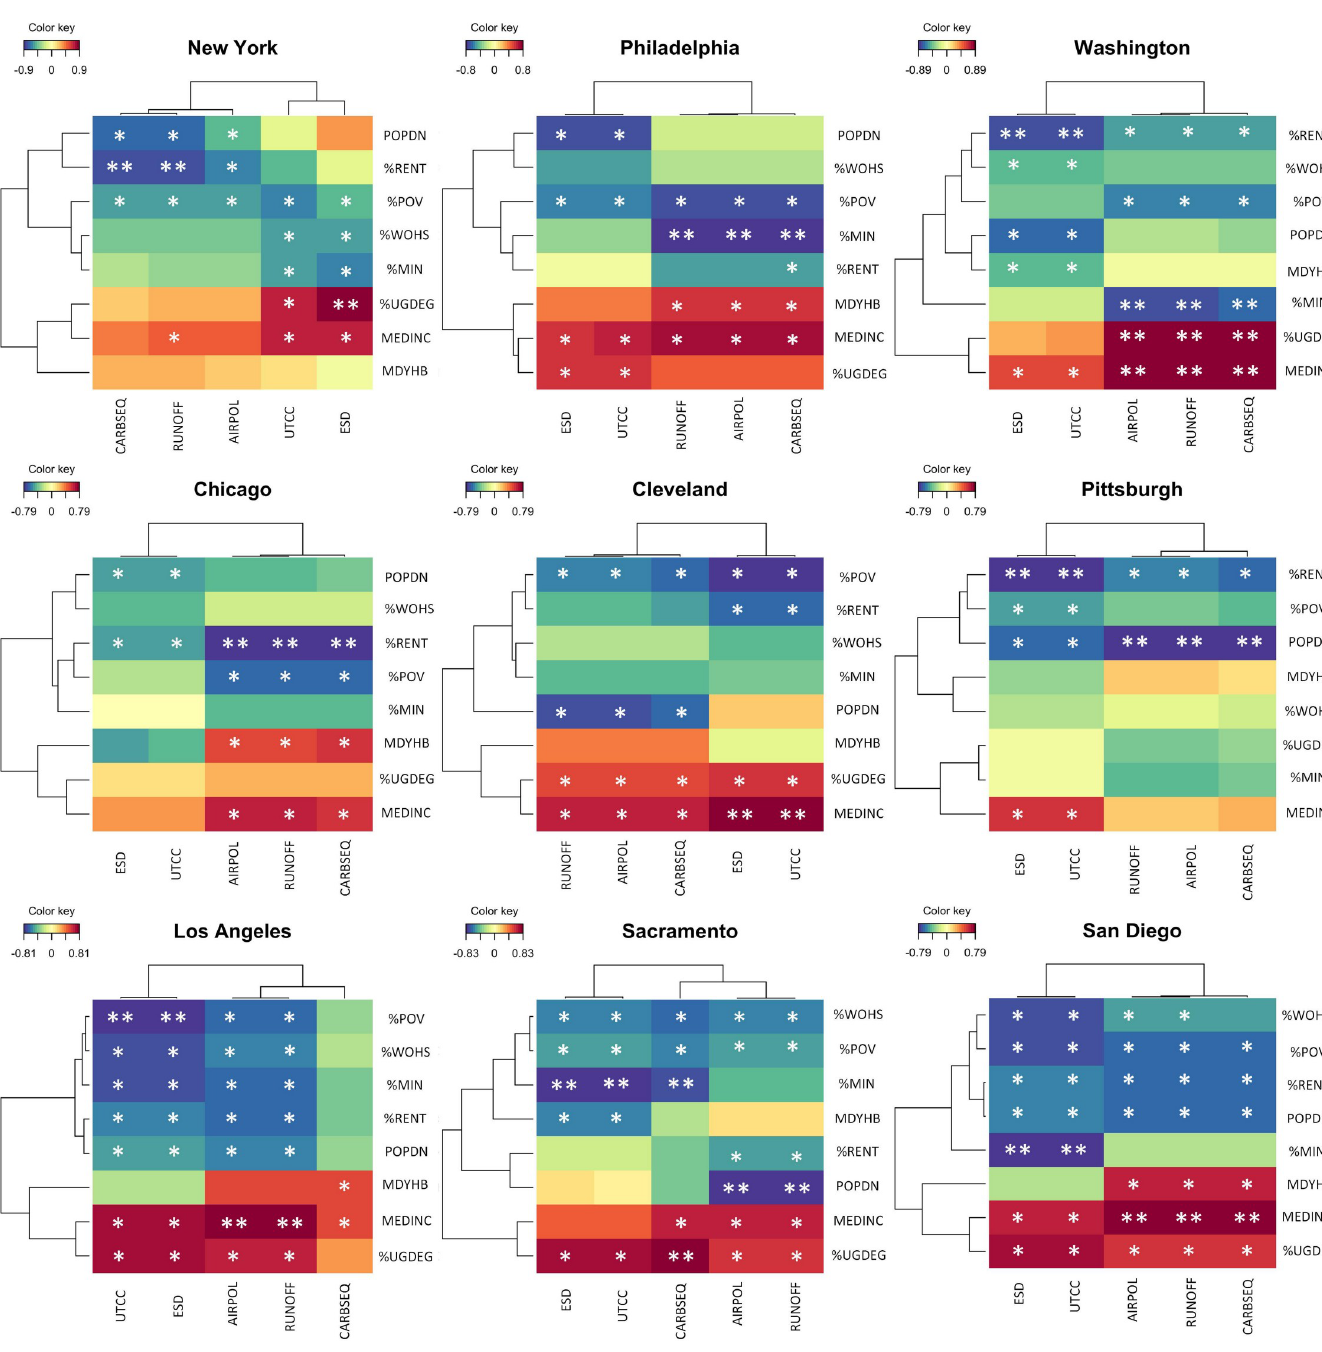
Fig 1. Clustered image maps illustrating partial least squares correlation analysis results for each city. Cells shaded with warm colors (red, orange) have positive correlations while cells shaded with cool colors (blue, green) have negative correlations. Variable pairs with a correlation value greater than or equal to 0.5 but less than 0.75 are marked with one asterisk; pairs greater than or equal to 0.75 but less than or equal to 1 were marked with two. The same thresholds (but negative) and markings are used for negative correlation